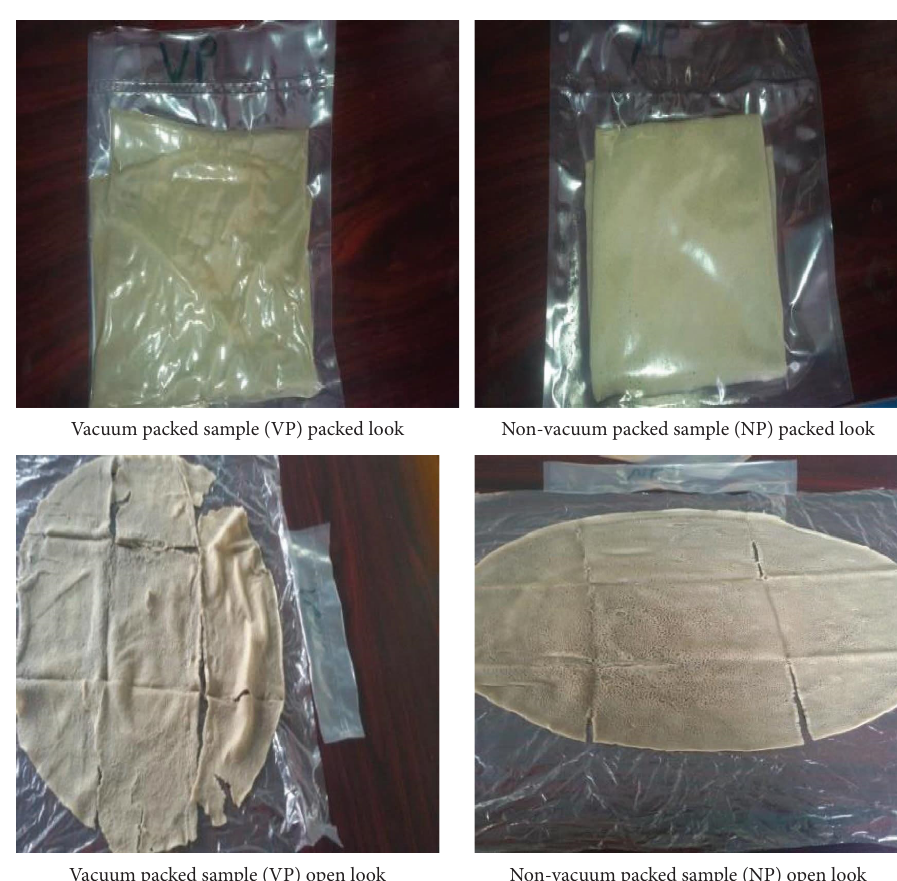
Figure 7: Pictures display a crumpling efect of vacuum packaging, via physical look or appearance of vacuum packed (VP) vs. nonvacuum packed (NP) injera samples. (a) Vacuum packed sample (VP) packed look. (b) Nonvacuum packed sample (NP) packed look. (c) Vacuum packed sample (VP) open look. (d) Nonvacuum packed sample (NP) open